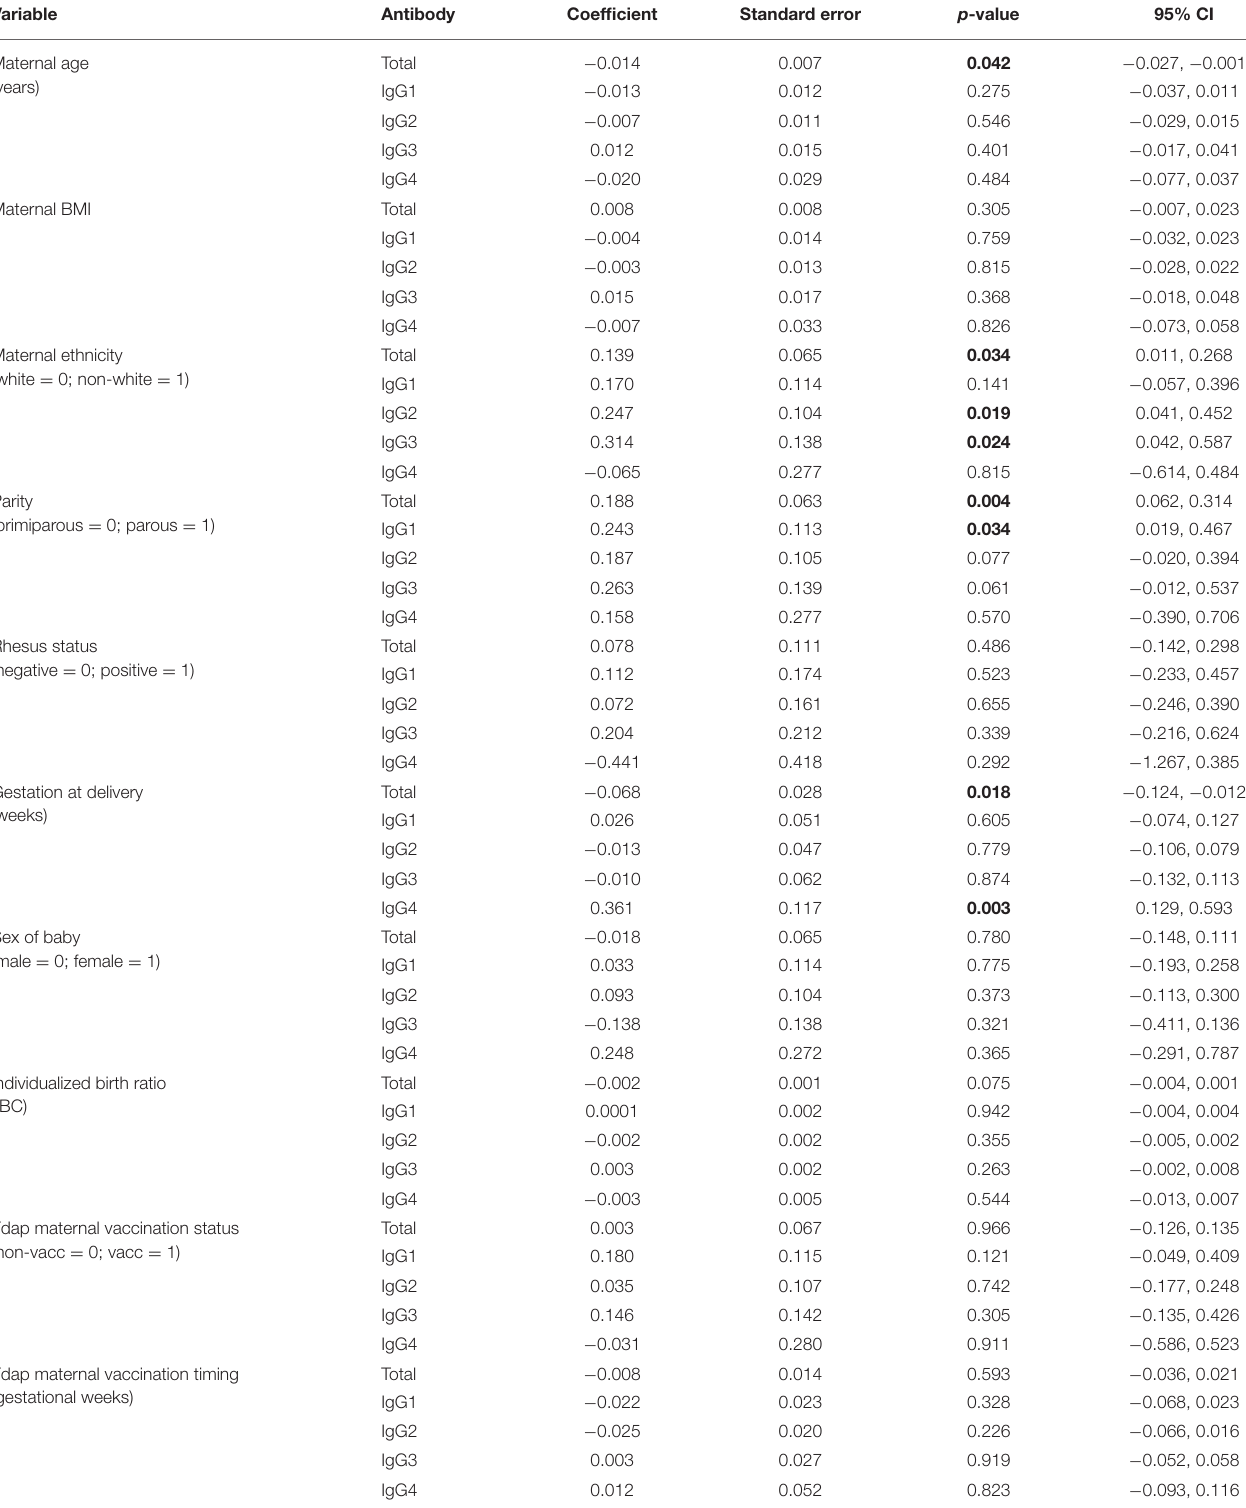
TABLE 2 | Unadjusted effects of clinical parameters on maternal antibody concentrations using simple linear regression based on n = 106 for total IgG and n = 116 for IgG subclasses.